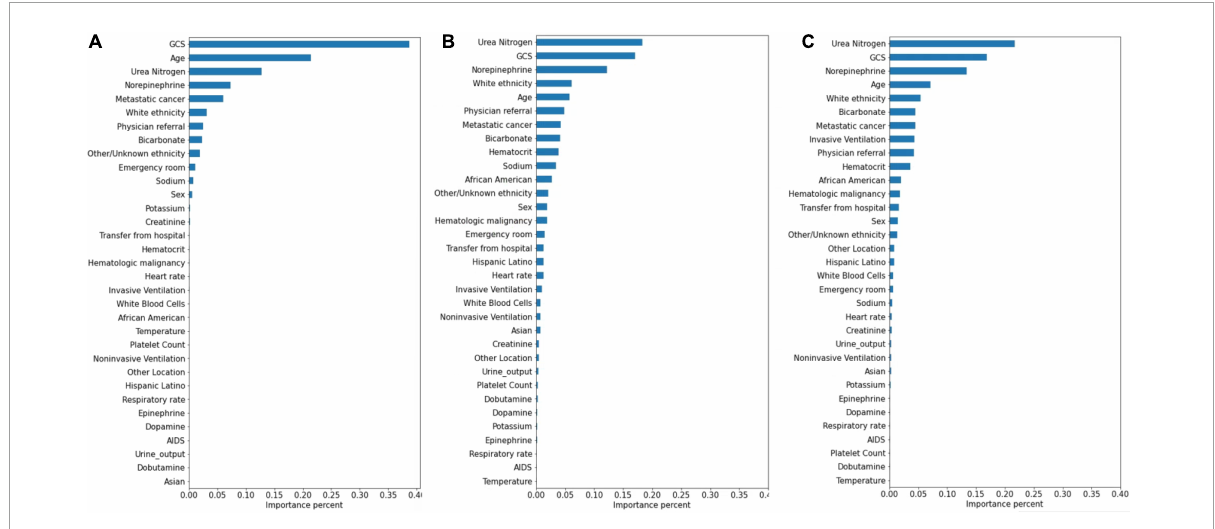
FIGURE4 Variable importance generated by mortality prediction models. (A) RNN; (B) GRU; (C)